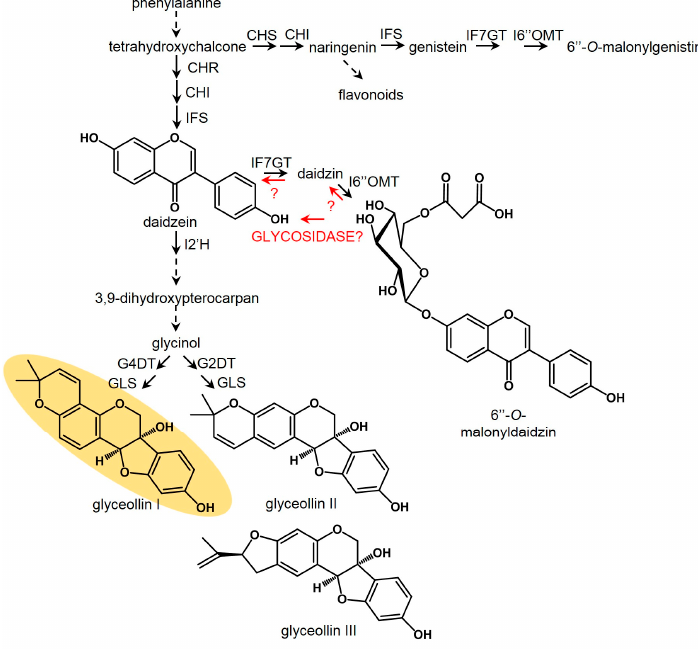
Figure 1. Glyceollin I biosynthetic pathway. In addition to de novo biosynthesis, the constitutively